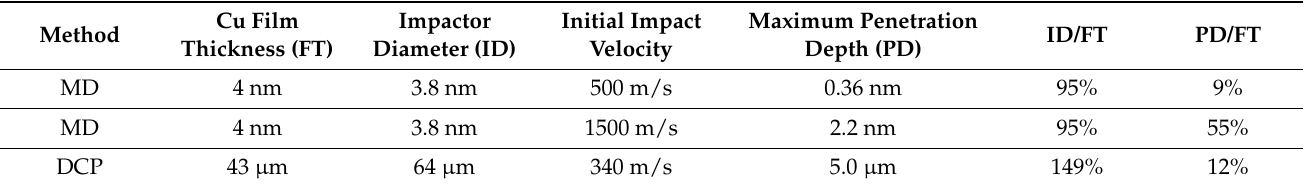
Table 4. Comparison of system setups.